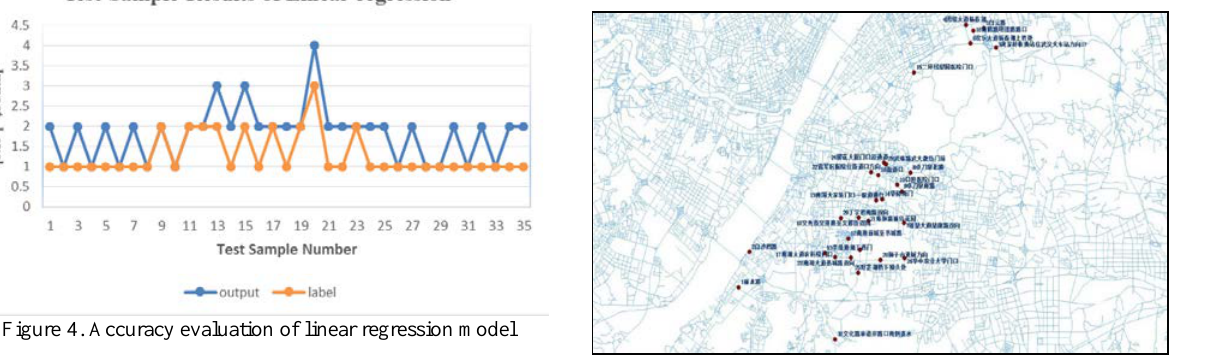
Figure 6. Distribution of waterlogging points over the years Table 6. Spatial data table of waterlogging points over the years